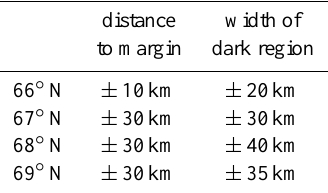
Table 1. Characteristics of dark region along different